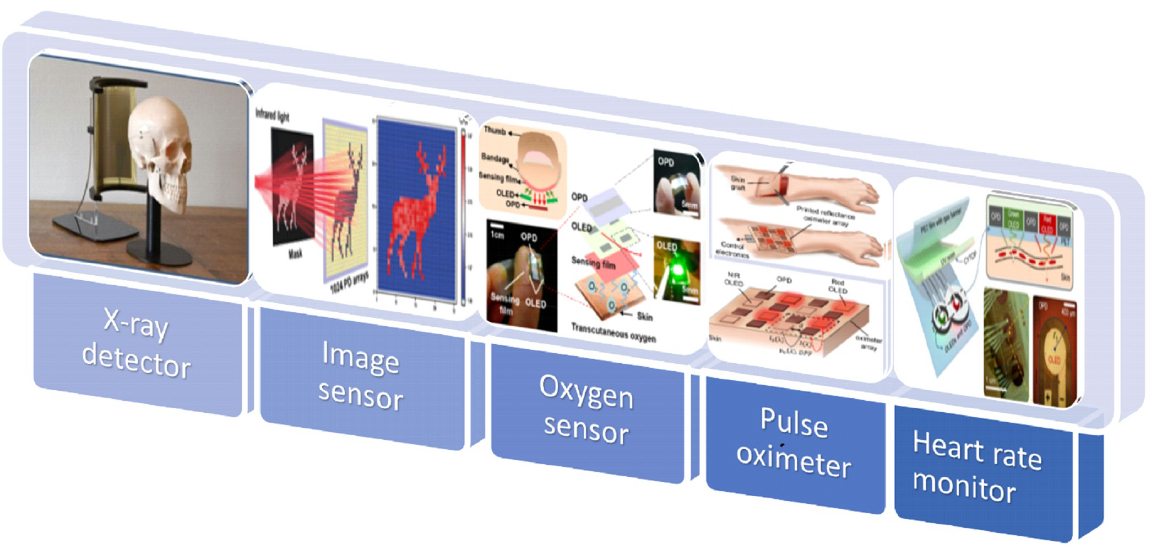
Figure 10. Schematic illustration of representative applications of organic material flexible photode- tectors.